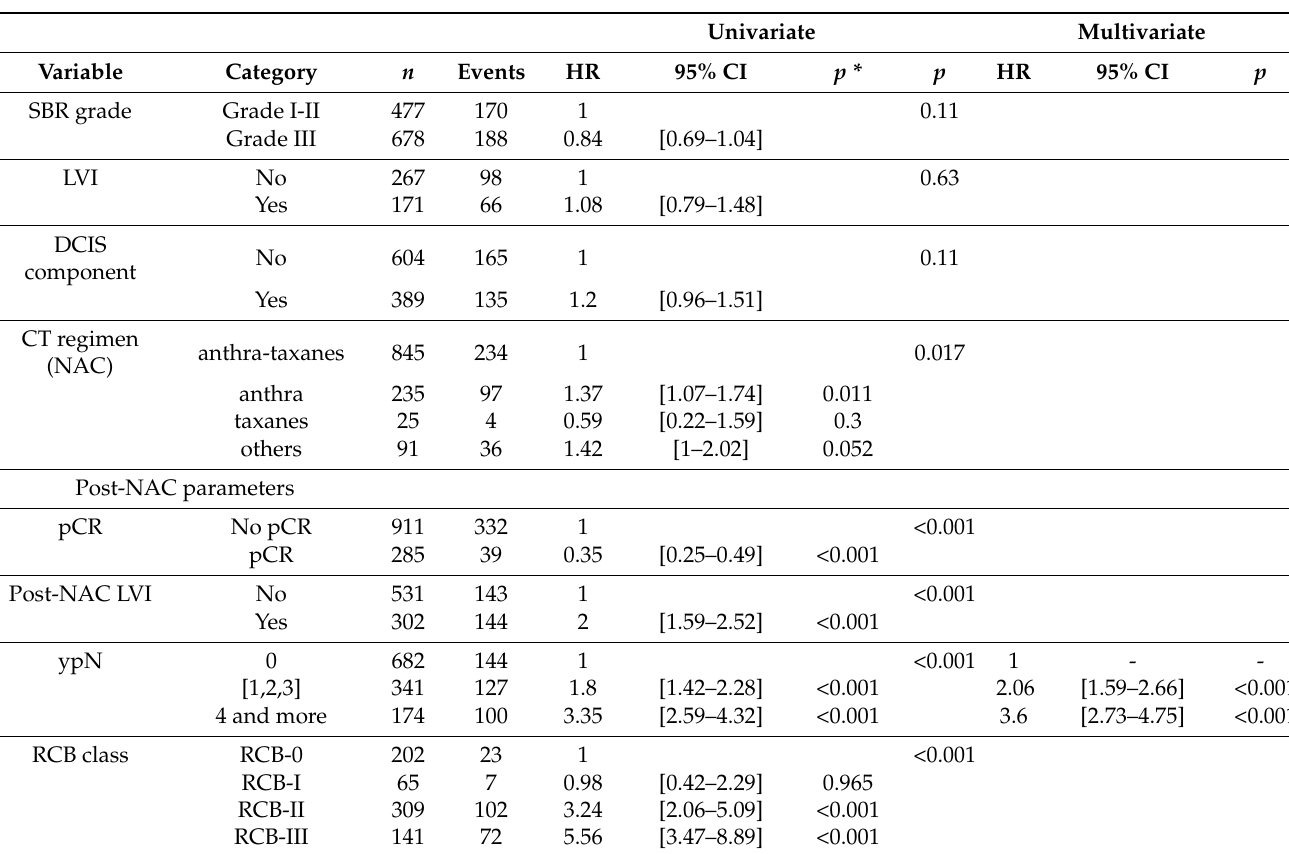
Table 3. Cont. Univariate